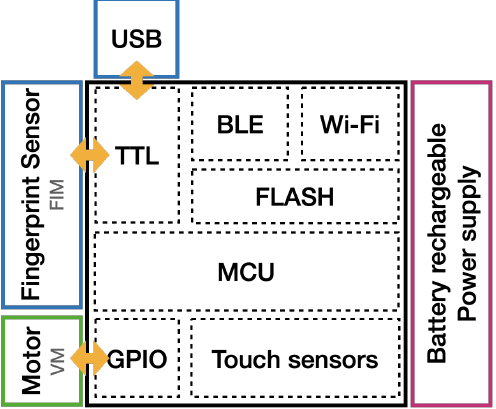
Figure 2. Functional modules of the prototype.